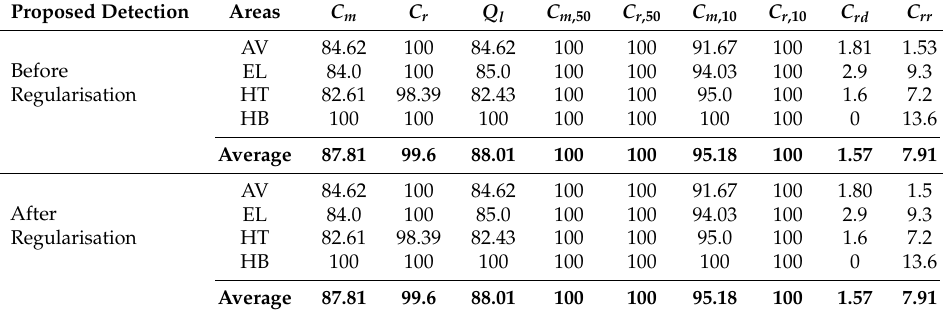
Table 4. Object-based building detection results on the Australian data sets before and after regularisation stage. ( C m = completeness, C r = correctness, are for all the buildings, 50 m 2 and over 10 m 2 in percentage; C rd = detection cross-lap (under-segmentation) and C rr = reference cross-lap (over-segmentation)